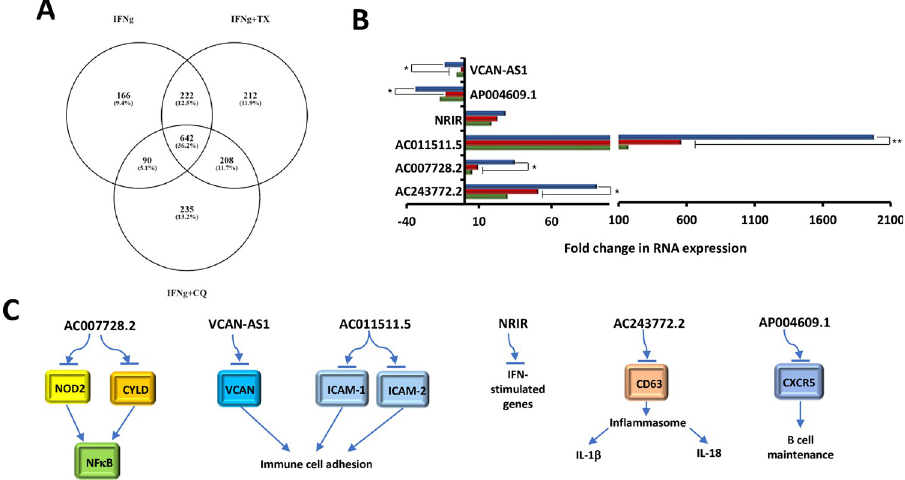
Fig 4. Antisense RNAs involved in MIAMI cells’ response to inflammation. A: Venn diagram showing numbers and percentages of unique and overlapping differentially regulated antisense RNA’s; B: Fold changes in selected antisense RNAs; C: Putative functions of selected RNAs; Green bar IFN γ , red bar IFN γ +TX, blue bar IFN γ +CQ. Values that are significantly different are indicated by bars and asterisks as follows: � , P � 0.05; �� , P � 0.01.